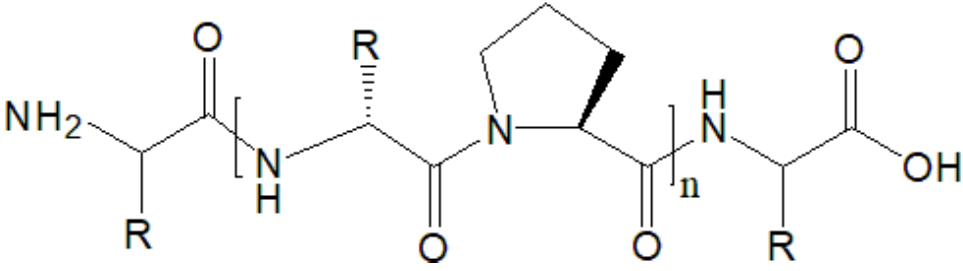
Figure 2. Chemical structure of collagen.